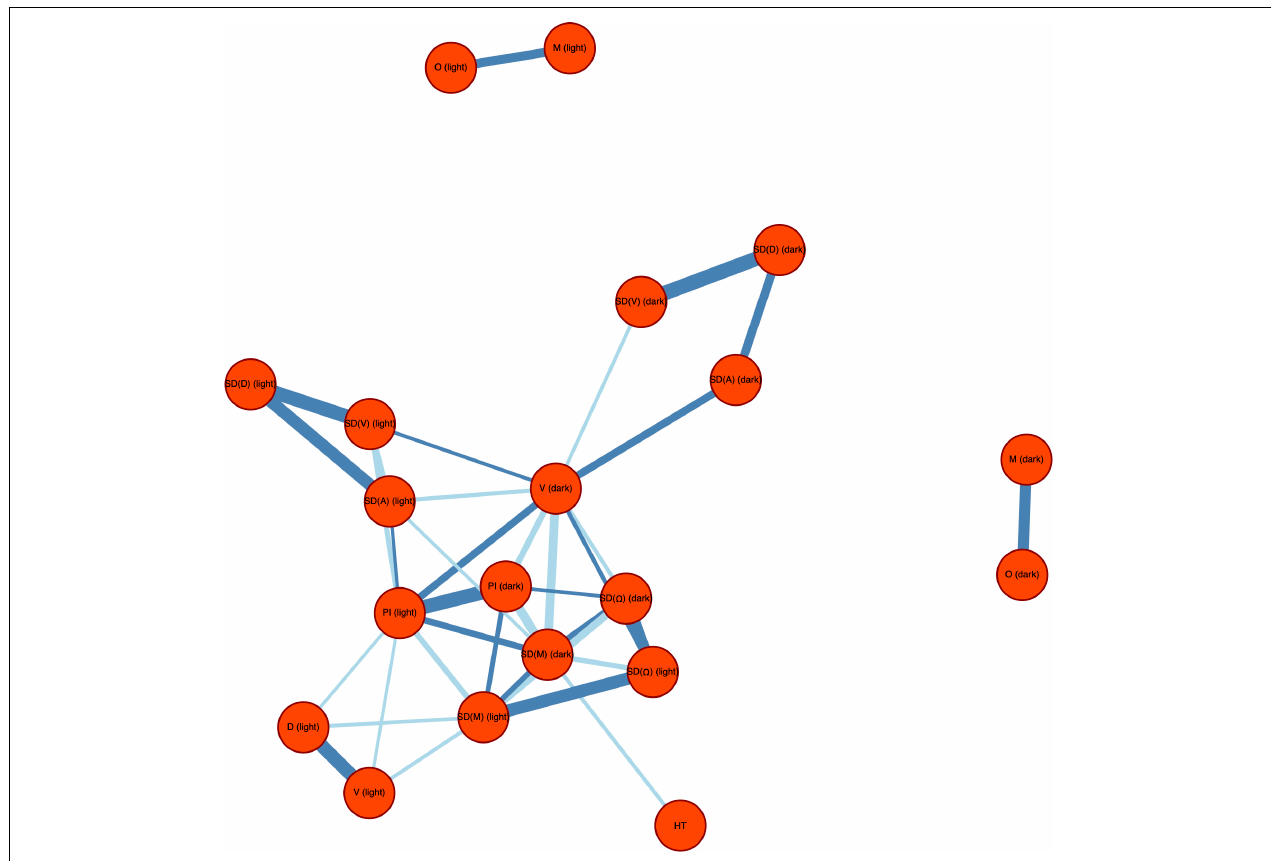
FIGURE 5 | Network of non-zero partial correlations between the explanatory variables for swimming behaviour during the light dark challenge assay: distance moved (D), velocity (V), acceleration (A), angular velocity ( (cid:127) ), meandering (M), percentage immobility (PI), and hatching time (HT) is represented by colour. The network is thresholded to lFDR < 0.20. Positive partial correlations are indicated by dark blue lines and negative partial correlations by light blue lines. Line width corresponds to the strength of